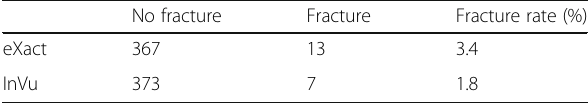
Table 5 Bond failure rates for female and male patients*